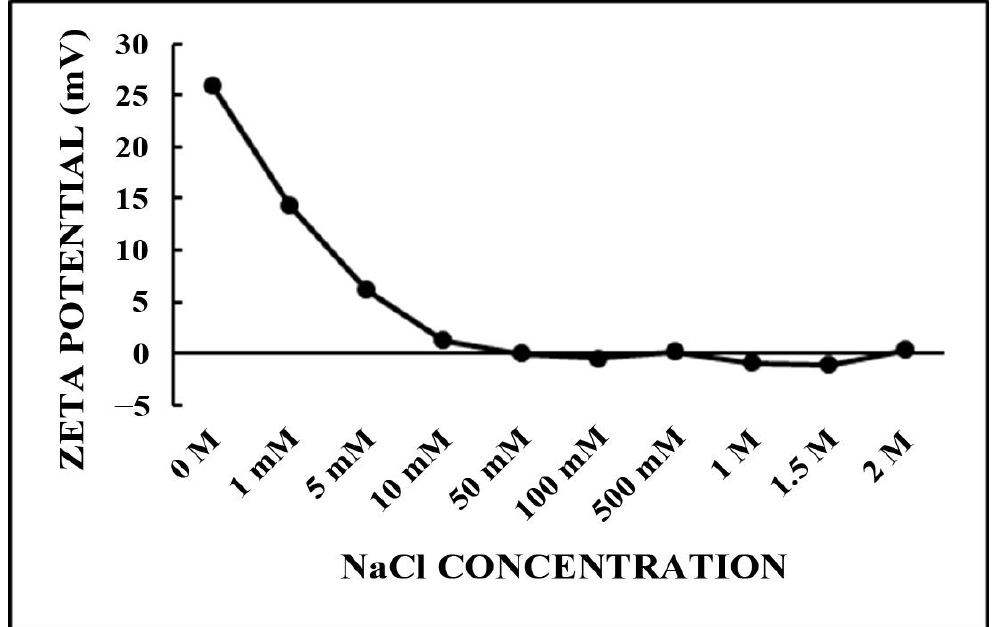
Figure 3. Zeta potential of NH 2 -PEO-PCL nanoparticles as a function of NaCl concentration.